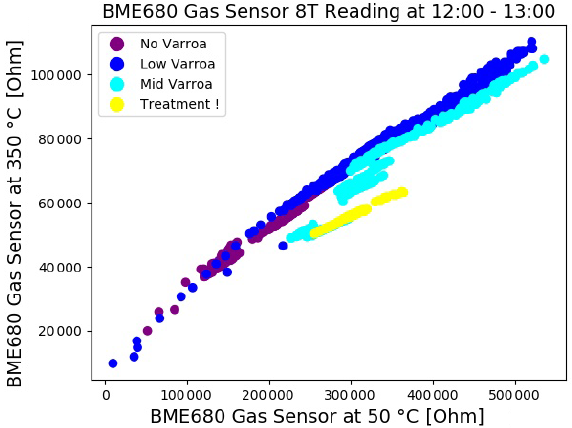
Figure 5. The extraction of campaign data for the period from 12:00 to 13:00CET for the BME680 sensor at 50 and 350 ◦ C.